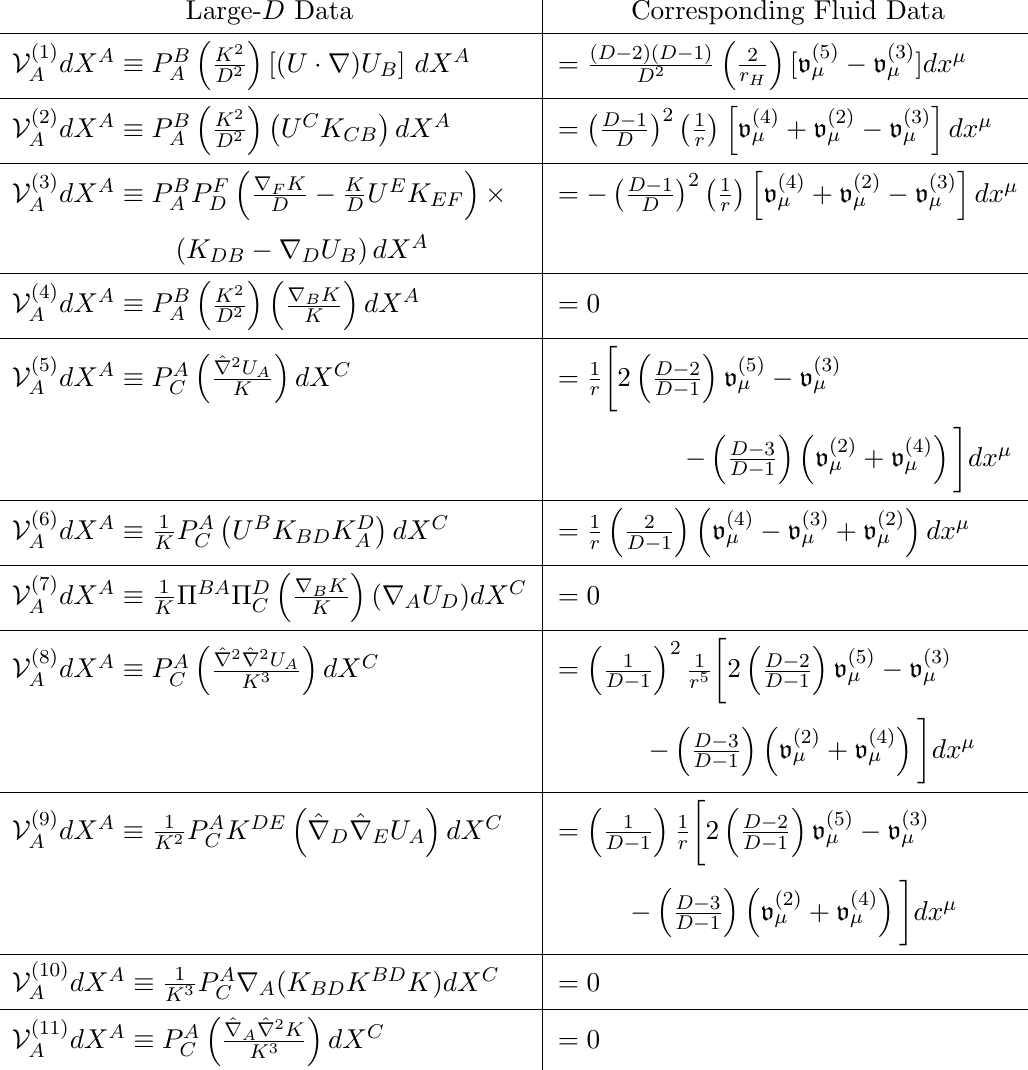
Table 5 . Vector large- D Data in terms of (cid:13)uid